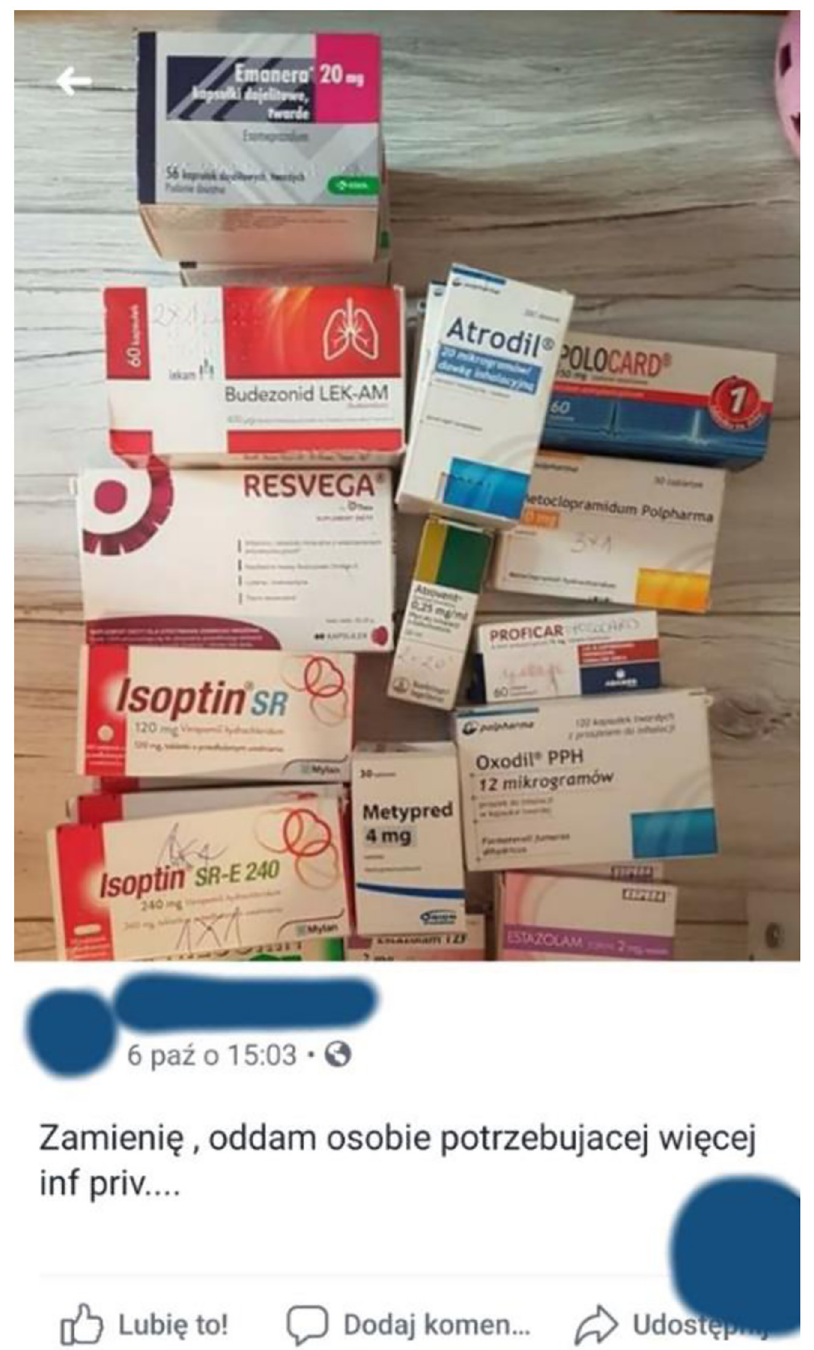
Fig 2. The example of the illegal online trade of medicines. Offer for estazolam (Estazolam 1 ). Source: Facebook. The URL address was not collected and is not reported to avoid the possible traceability of the Facebook user and to not to contravene the data protection or the GDPR. The presented figure is similar but not identical (partial screenshot with concealed parts of the picture) to the original image and is therefore only for illustrative purposes.